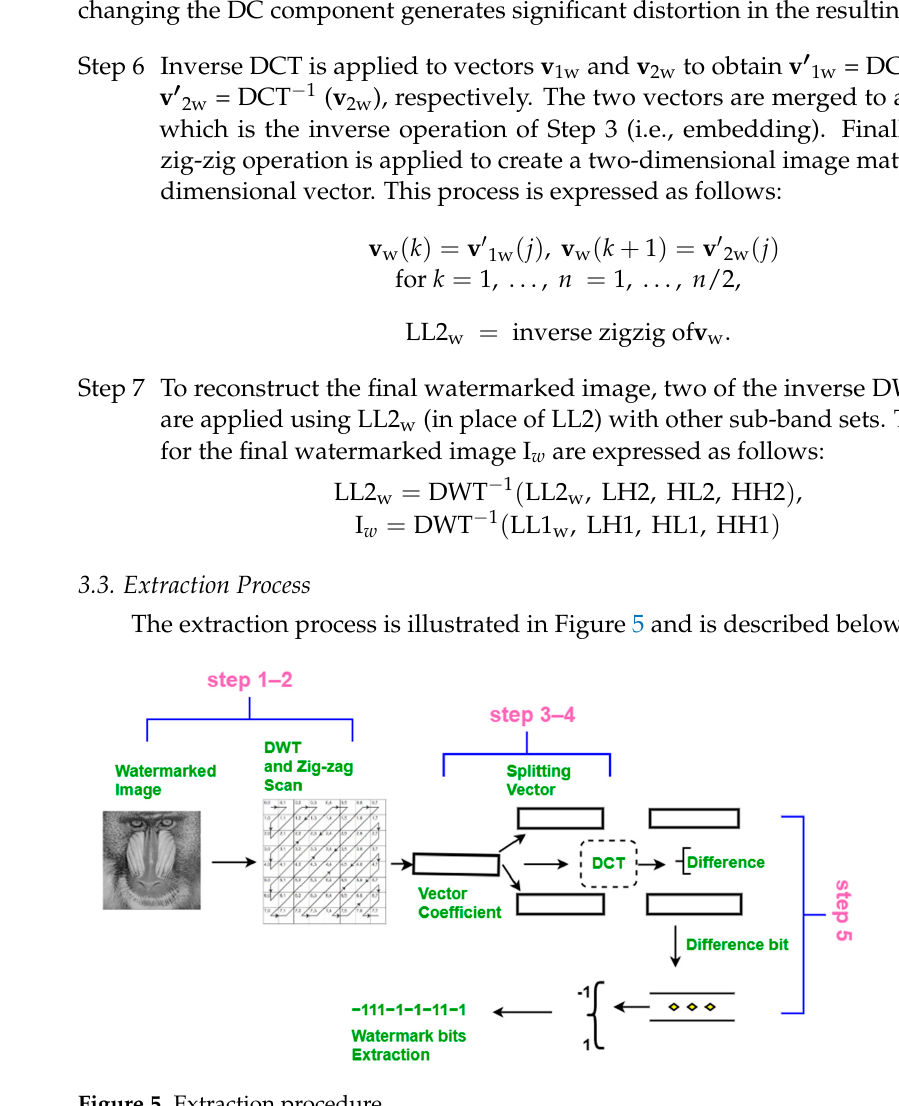
Figure 5. Extraction procedure.